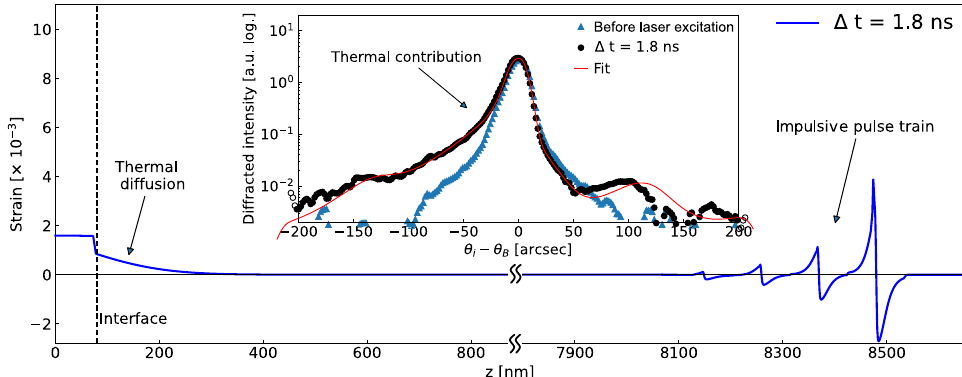
Figure 3. Strain profile of GaAs substrate at (cid:31) t = 1.8 ns, and corresponding Bragg diffraction curve together with a fit result (inset). The non-homogeneous temperature distribution near the interface gives rise to the asymmetry of the curve to the part of the lower angle.